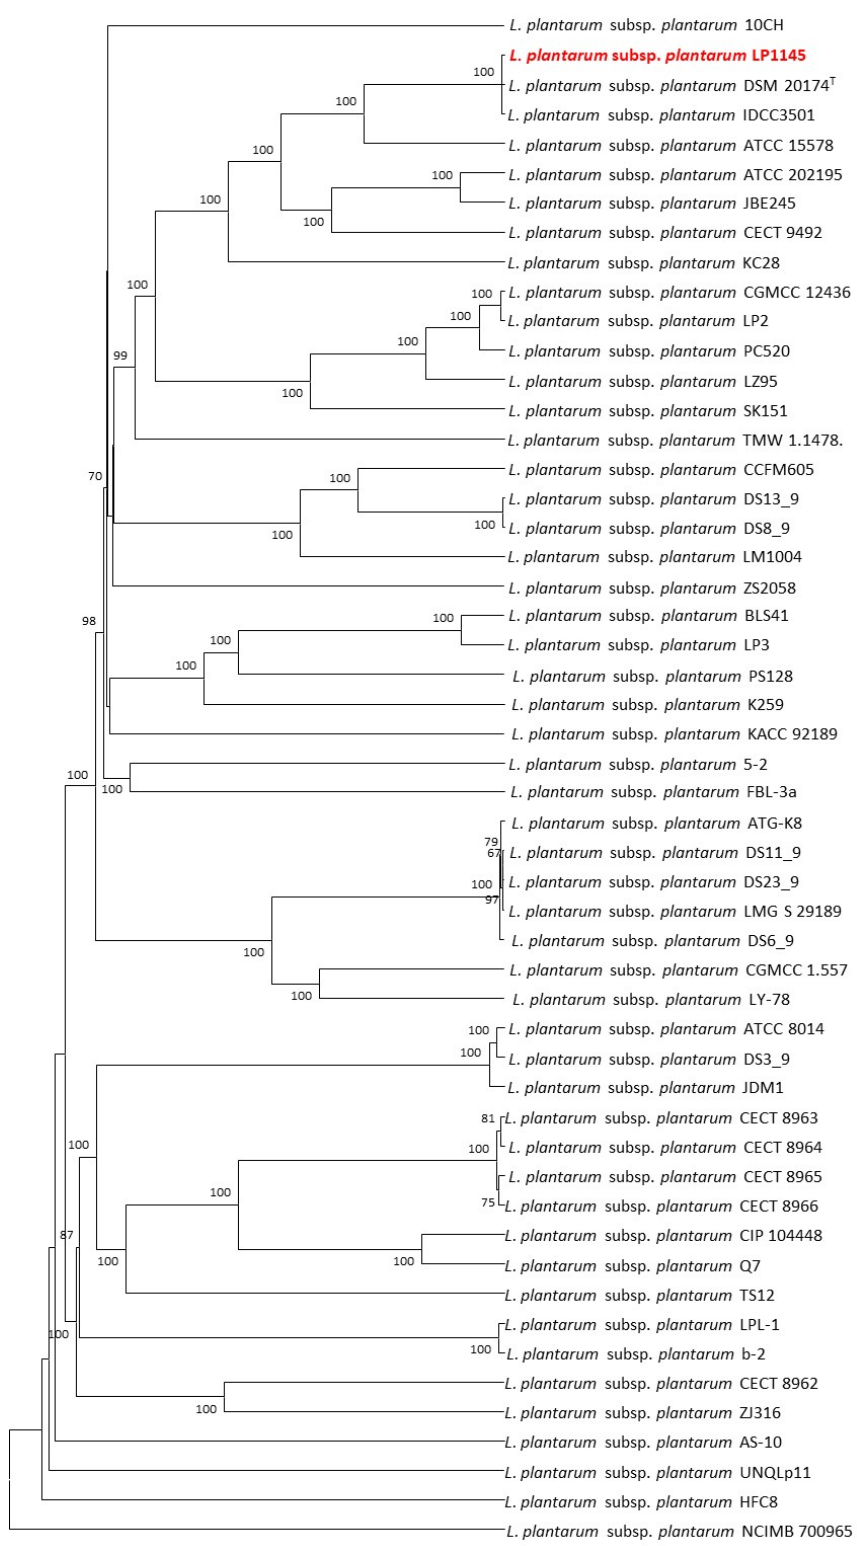
Figure 8. The allele-based UPGMA tree constructed with cgMLST profiles for the 52 Lactiplantibacillus plantarum subsp. plantarum strains on the basis of a comparison of 2233 differentiated core genes.